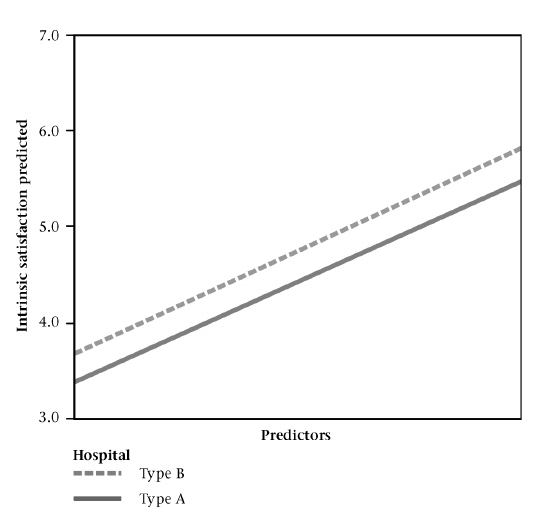
Figure 6: Predictors of Intrinsic Satisfaction